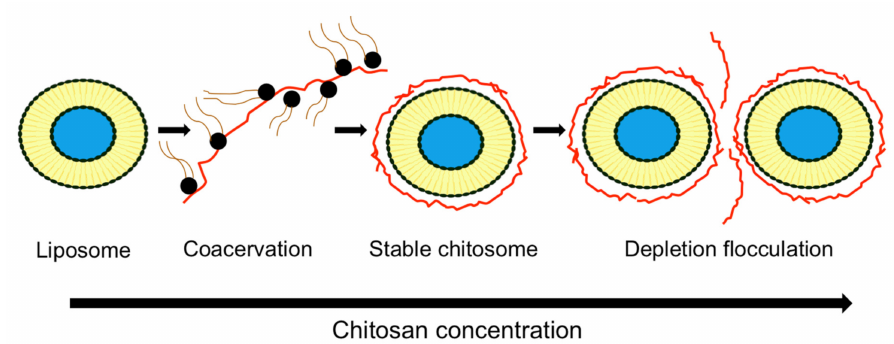
Figure 3. Proposed mechanism of liposome stability controlled by chitosan